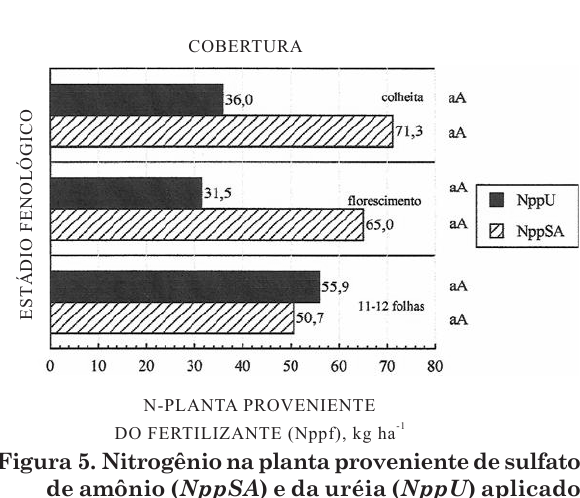
Figura 5. Nitrogênio na planta proveniente de sulfato de amônio ( NppSA ) e da uréia ( NppU ) aplicado em cobertura e acumulado em três estádios do ciclo da cultura de milho, na safra 2000/2001, em sistema plantio direto. DMS (entre fontes – letras minúsculas) = 36,6ns. DMS (entre épocas – letras maiúsculas) = 29,9ns. CV (%) = 32,3.